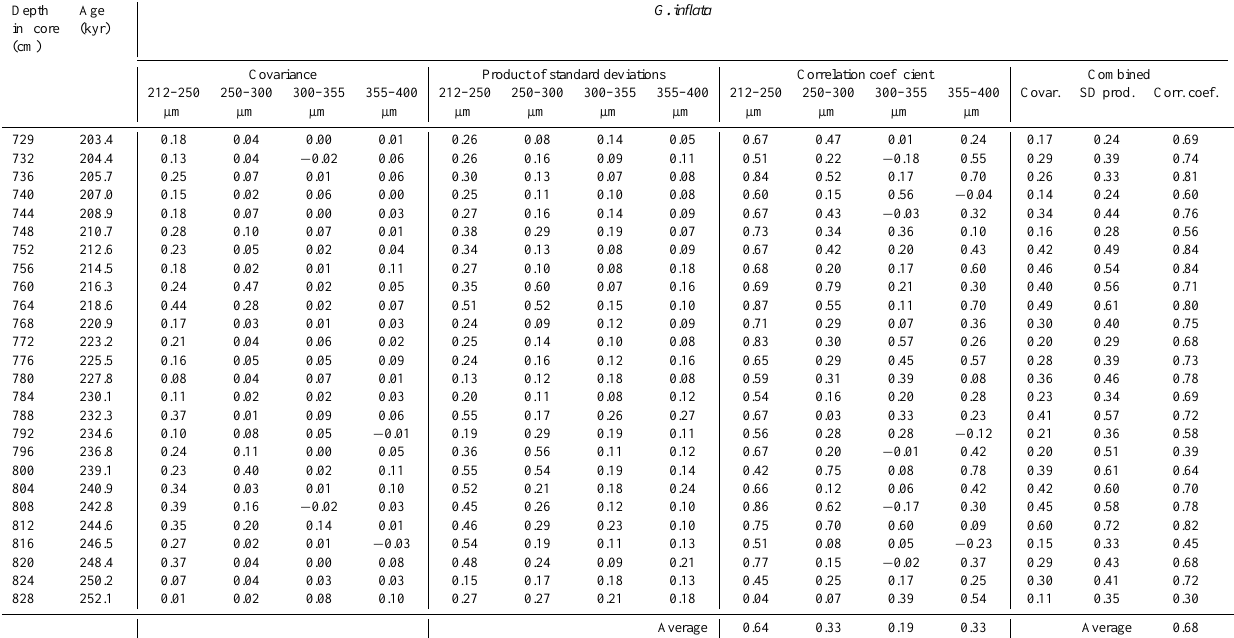
Table 5. Covariance of studied planktonic foraminifera. Test values for covariance and correlation coefficient of G. inflata . Depth Age (kyr) in core (cm)